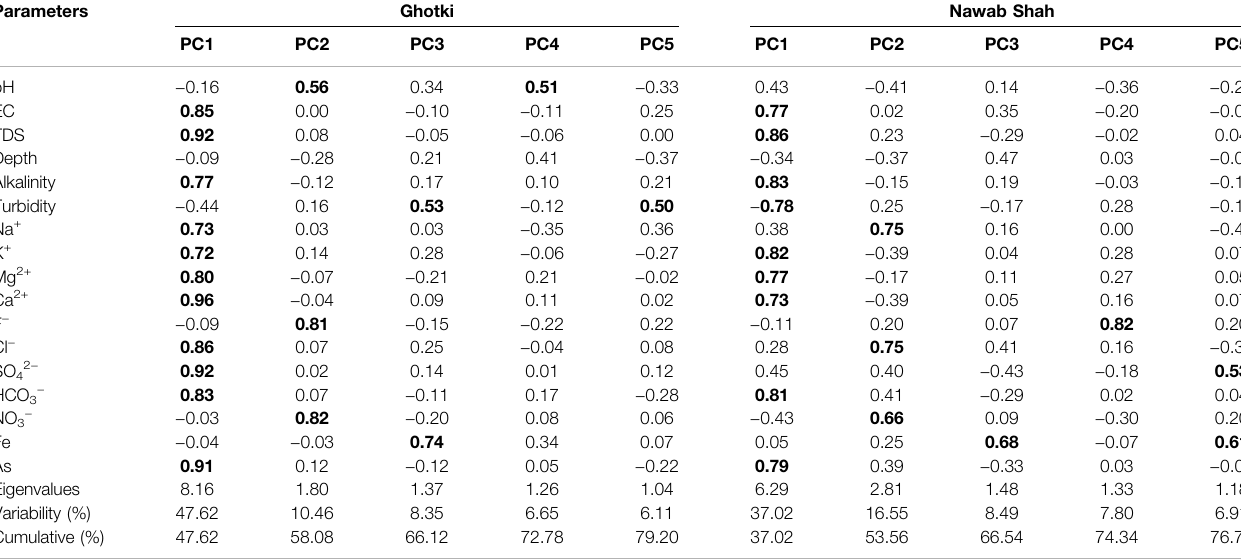
TABLE 2 | Principal component analysis of selected groundwater parameters for the Ghotki and Nawab Shah districts.